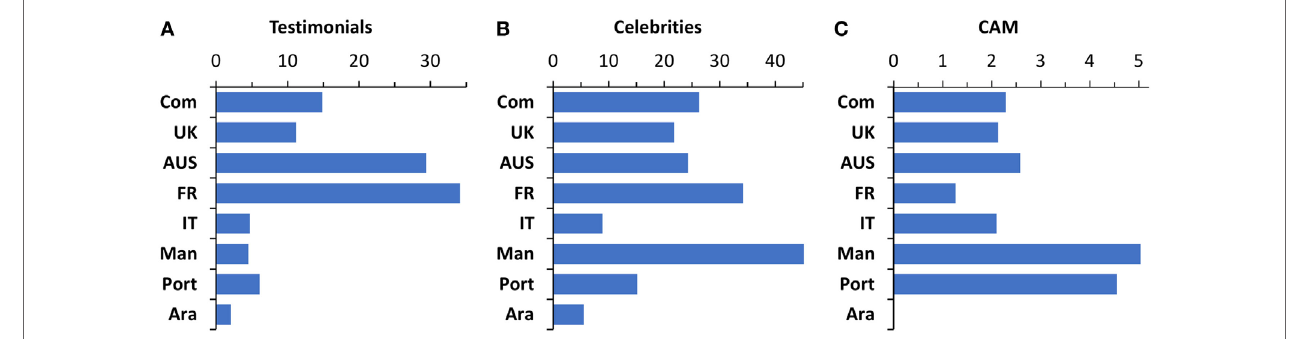
FigUre 1 | Percentage of webpages containing testimonials (a) or mentioning celebrities (b) or complementary and alternative medicine (c)